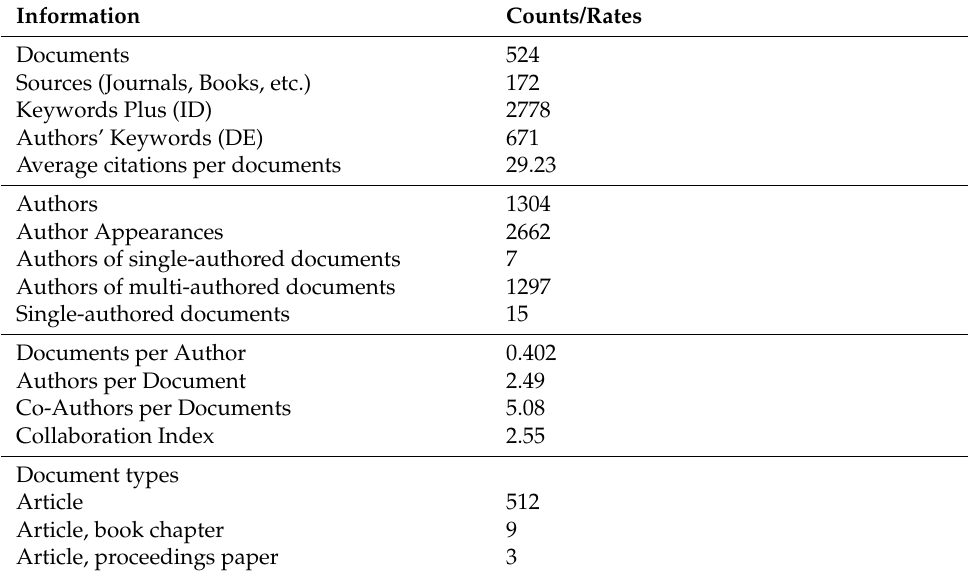
Table 1. Main information about Arcobacter